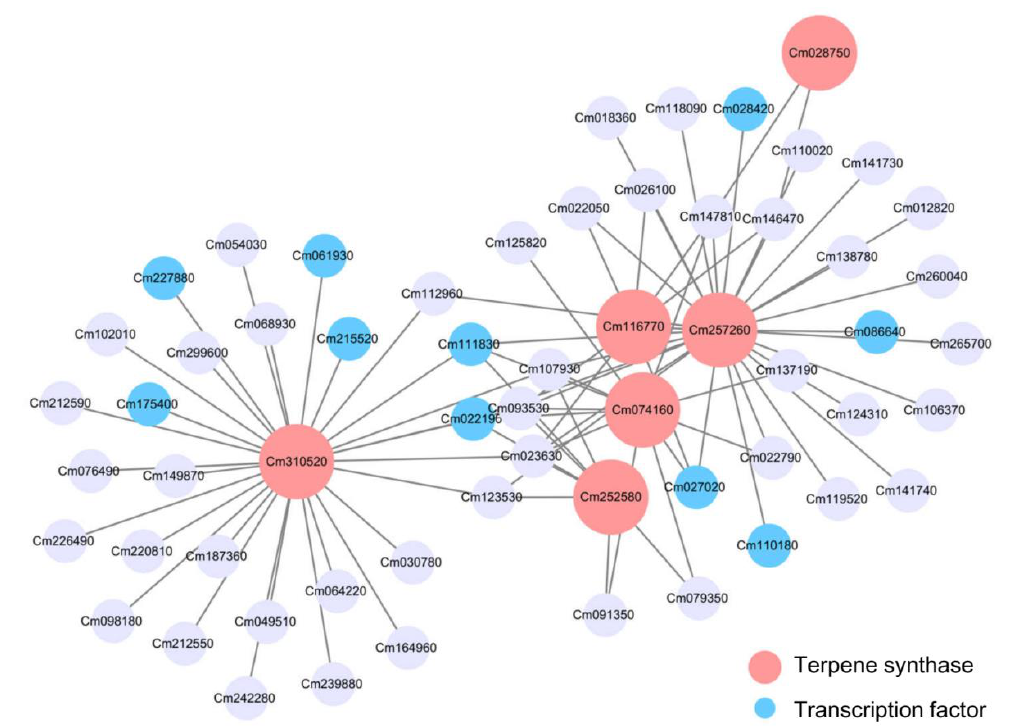
Figure 7. Gene co-expression subnetwork of Module Red. Network was reconstructed by edge weight cutoff = 0.35 and visualize by cytoscape. Gene IDs and annotations in Module Red subnetwork were listed in Table S4.